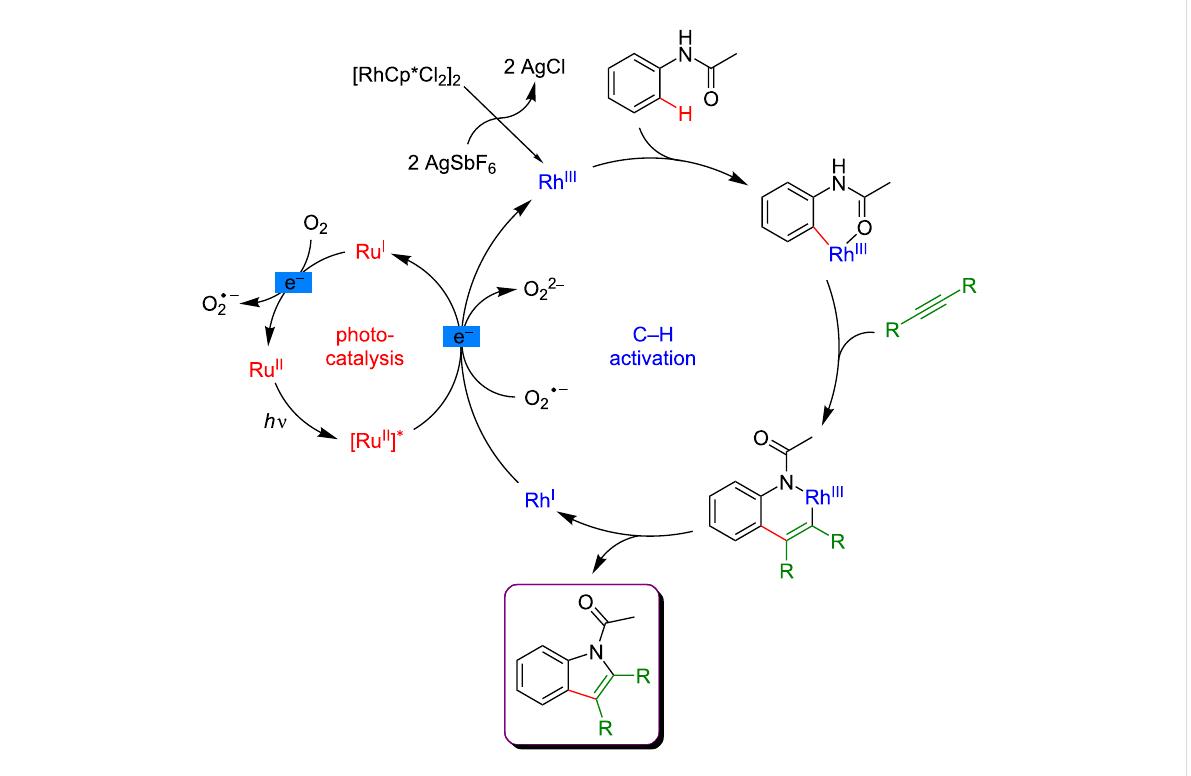
Figure 18: Proposed mechanism for the indole synthesis via dual catalysis.